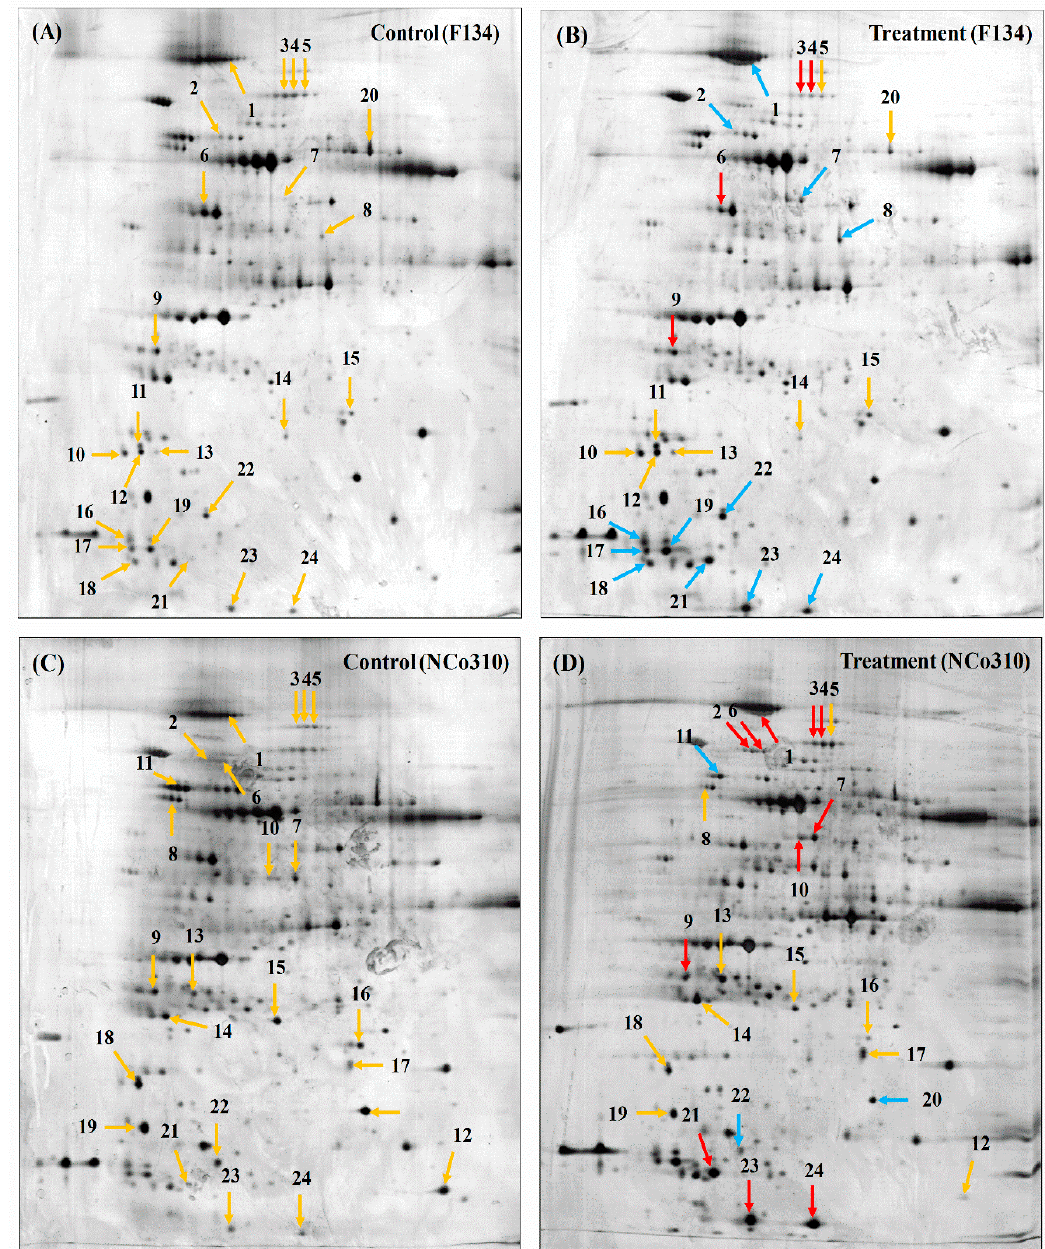
Figure 1. 2-DE SDS-PAGE gel pictures of sugarcane varieties F134 and NCo310 with their controls. ( A ) control (F134), ( B ) treatment (F134), ( C ) control (NCo310), and ( D ) treatment (NCo310). Yellow for the protein spots of interest, red for upregulated proteins, and blue for downregulated proteins.